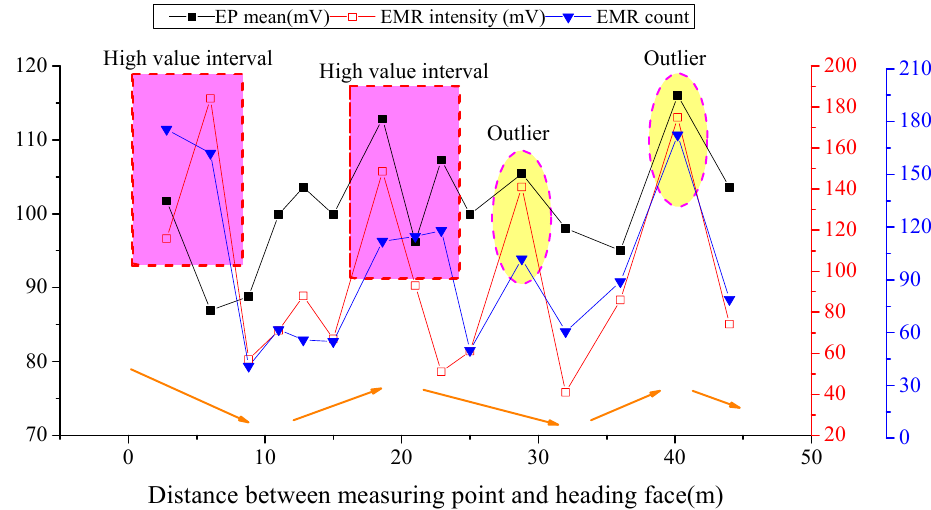
Figure 6. Measuring results of EP and EMR, along with driving distance behind the driving face.